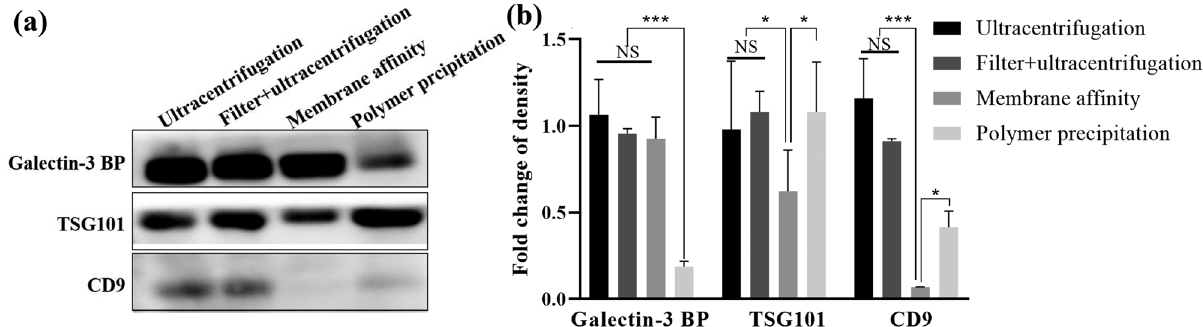
Figure 5: Surface marker expression pro fi les in exosome preparations. ( a ) Western blot for Galectin - 3 BP, Tsg101, and CD9 expression in each exosome preparation ( 20 µL of total exosomal protein was loaded ) . ( b ) Quanti fi cation of the expression levels of Galectin - 3 BP, Tsg101, and CD9 in each exosome preparation. The results are the mean ± SE of the mean of three independent experiments. One - way analysis